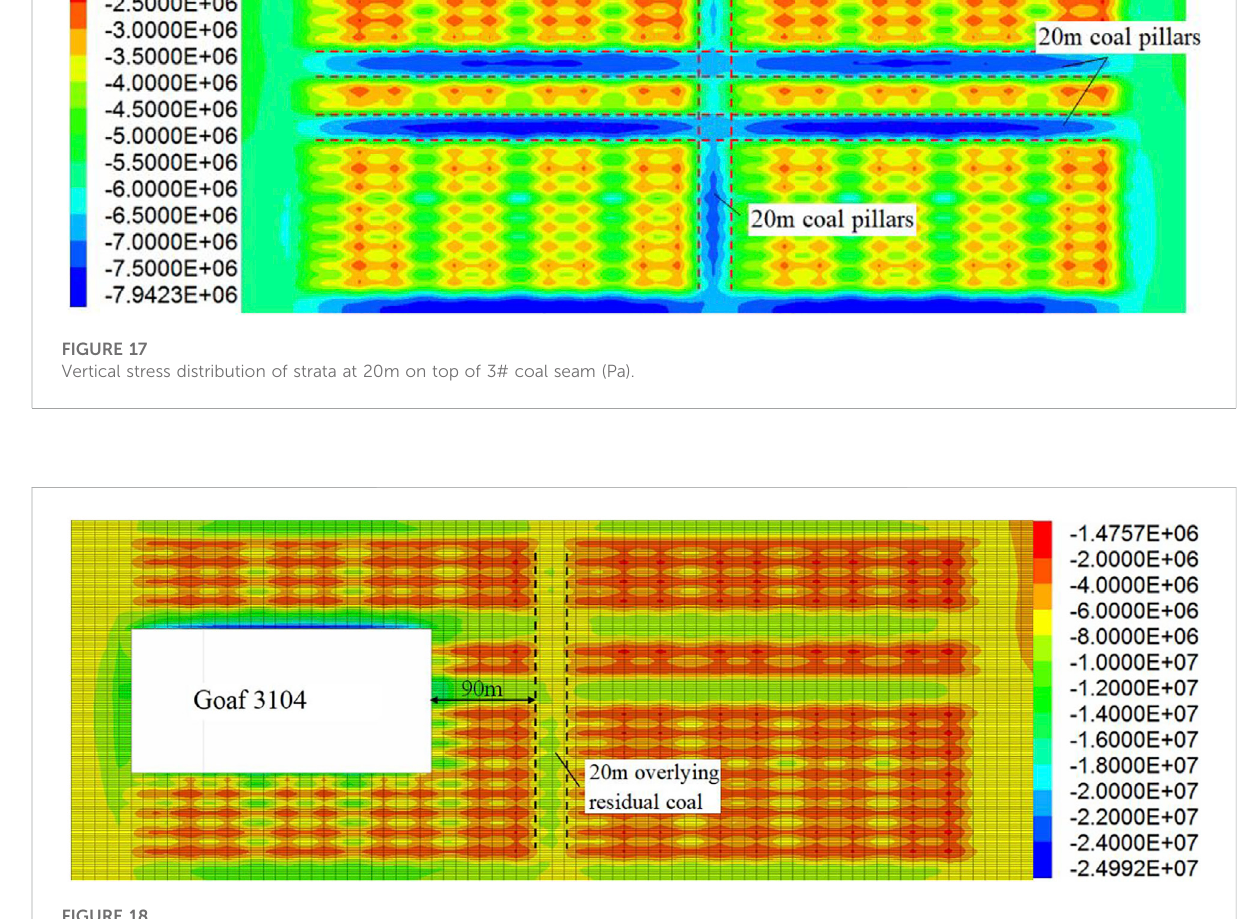
FIGURE 18 Cloud diagram of vertical stress distribution at 90m of overlying residual coal pillar